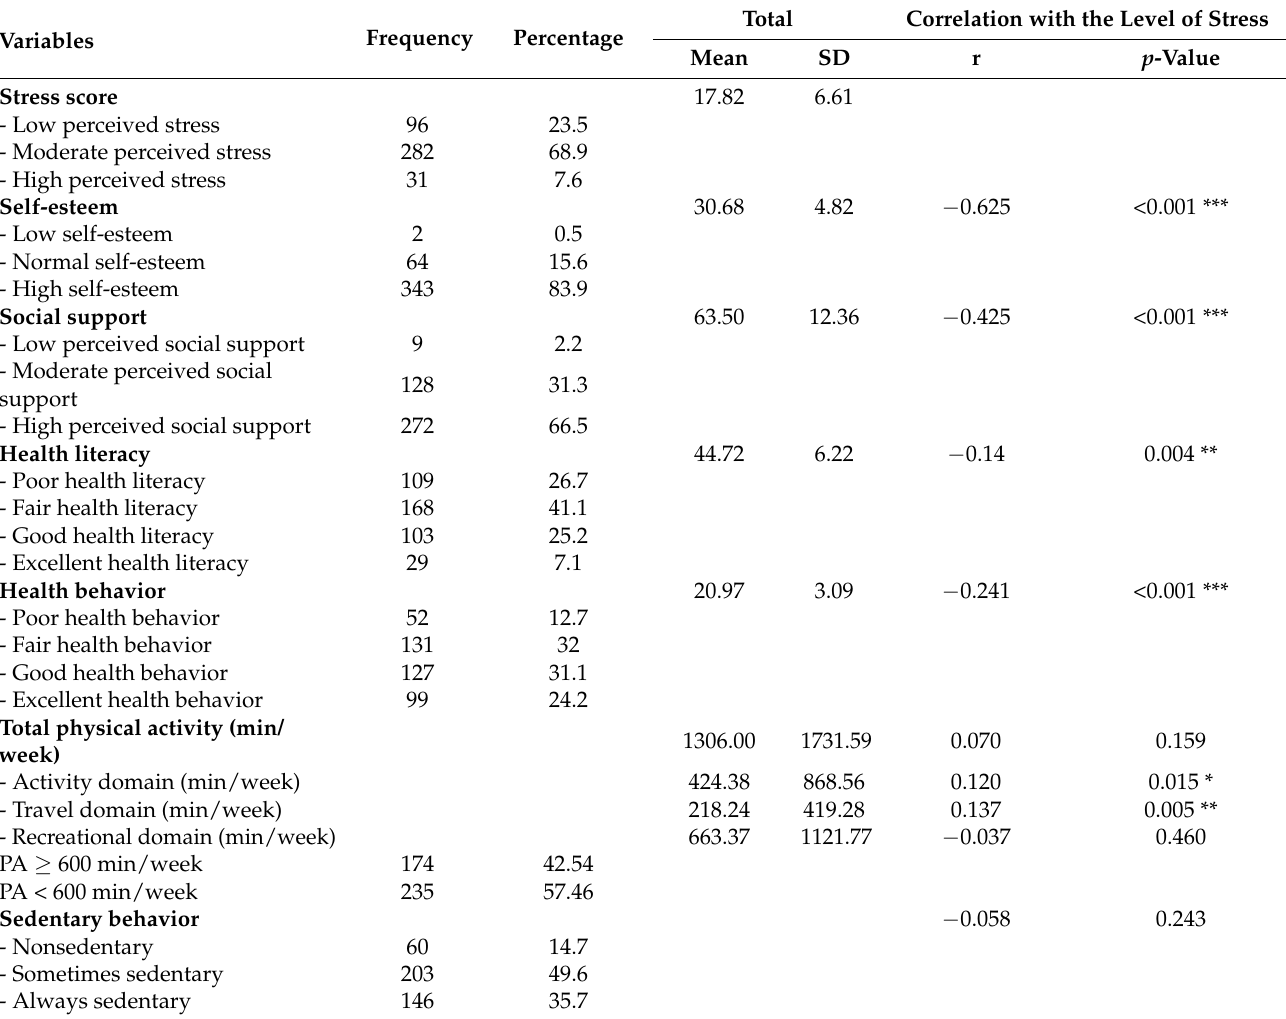
Table 2. Correlations between stress level and self-esteem, social support, health literacy, health behavior, physical activity, and sedentary